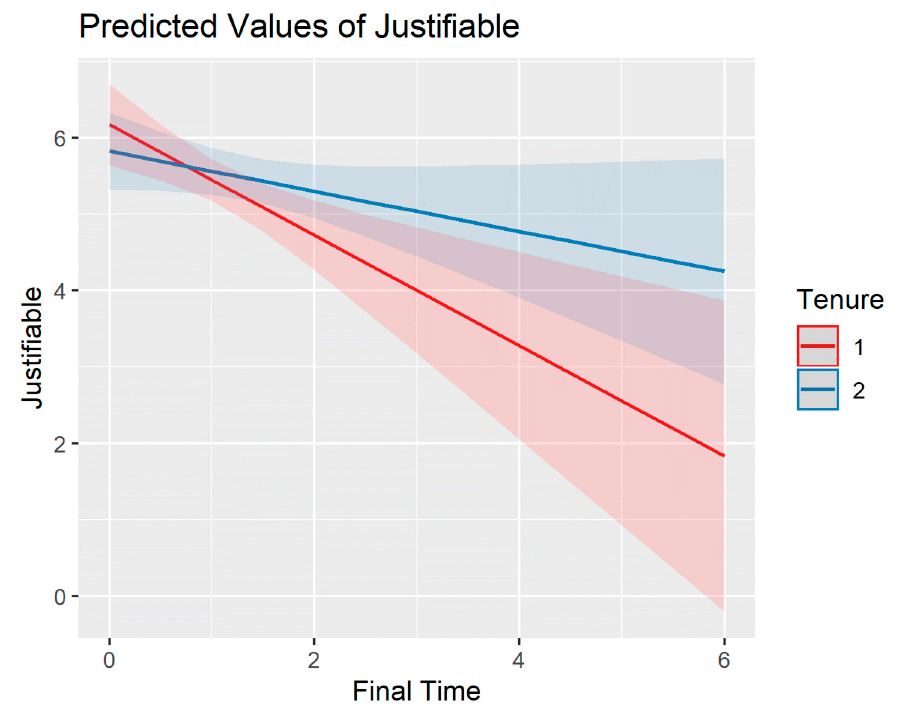
Figure 2. Tenure as a moderator of the relationship between publishing time and publishing time justifiability.